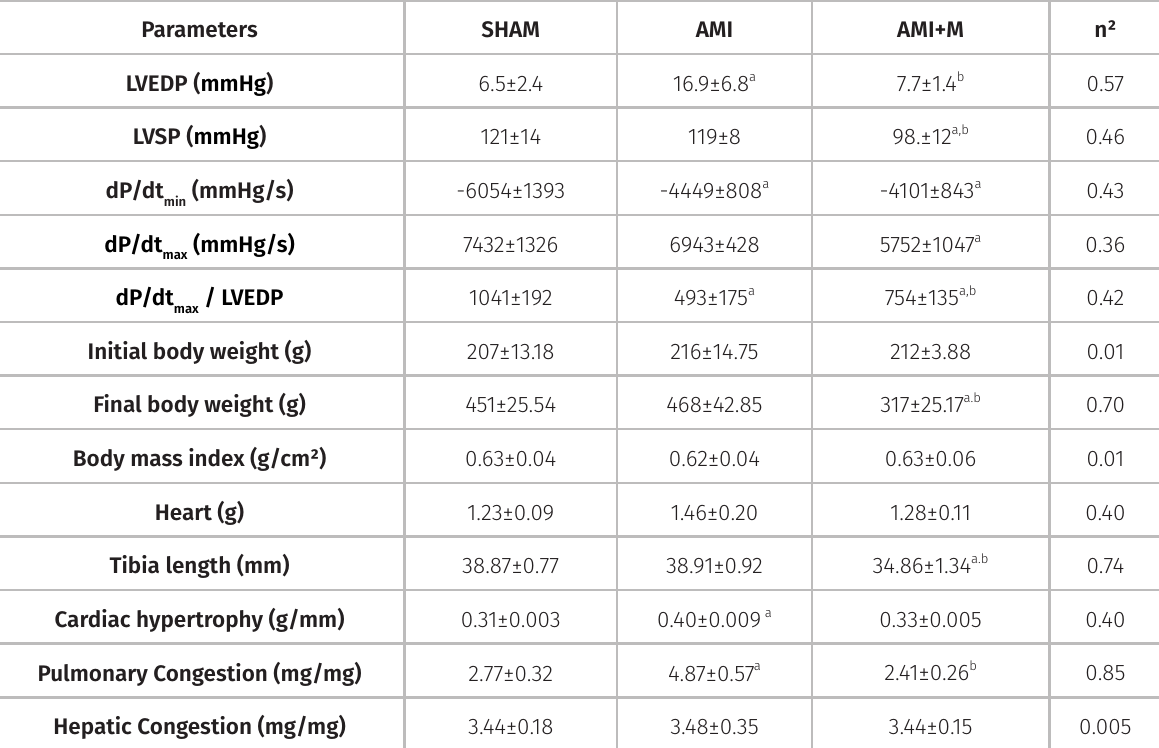
Table II. Cardiac catheterization data and morphometric analysis 56 days after surgery. Parameters